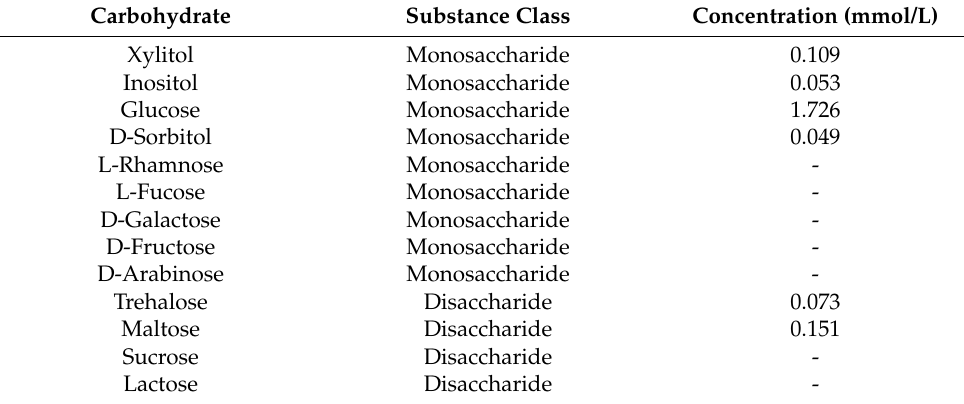
Table 1. Carbohydrate components in hemolymph of L. vannamei